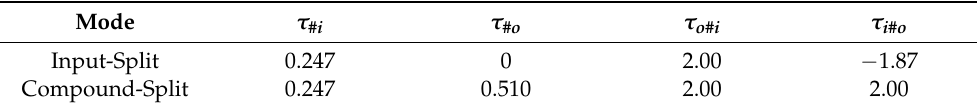
Table 2. Basic functional parameters of Voltec derived in